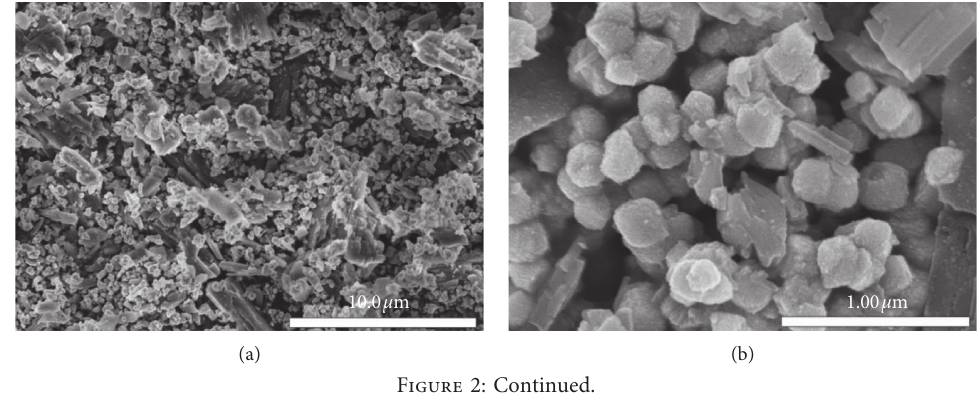
Figure 1: XRD patterns of MIL-53 samples synthesized at the hydrothermal temperature of 150 ° C: (a) FeCl FeCl 3 /TA molar ratio of 1/2 and 1/3; MIL-53 samples with an FeCl 3 /TA molar ratio of 1/2 synthesized at the hydrothermal temperature of (c) 100, 120, and 150 ° C; (d) 180 °